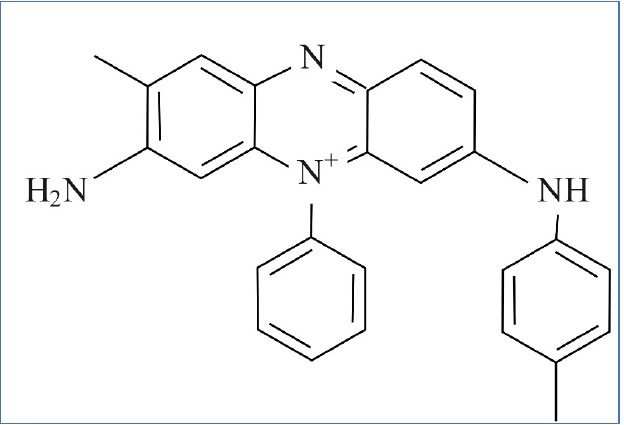
Figure 12. Structure of the mauveine A aniline dye.